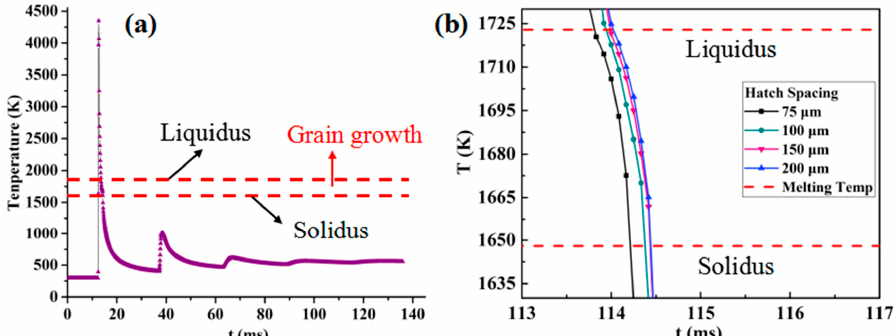
Figure 5. ( a ) FEM temperature-time curve of 316L SS samples simulated based on their optimized parameters and ( b ) its magnified temperature-time curves between the solidus and liquidus for different process parameters.